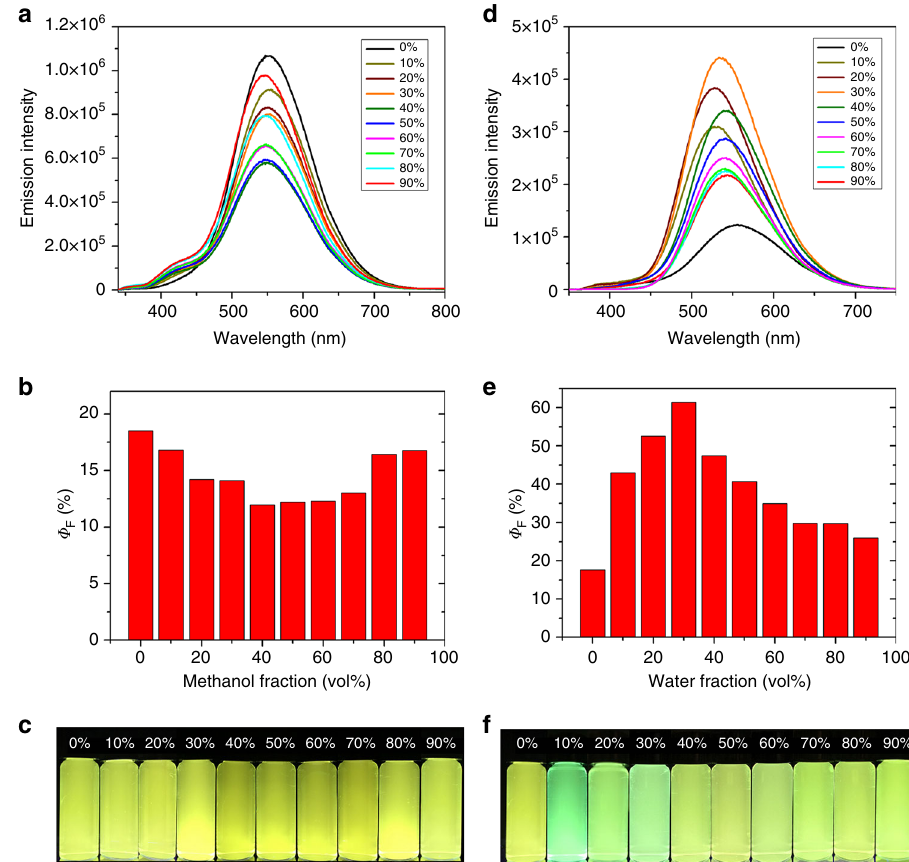
Fig. 6 AIE of G3 . a Fluorescence spectra ( λ ex = 320 nm, c = 1.0 µ M), b quantum yields, and c photographs of G3 in CH 3 CN/methanol with various methanol fractions; d fl uorescence spectra ( λ ex = 320 nm, c = 1.0 µ M), e quantum yields, and f photographs of G3 in CH 3 CN/water with various water fractions. G3 samples were excitation at 365 nm on 298 K ( c = 1.0 μ